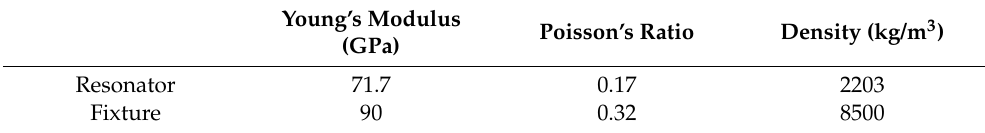
Figure 3. Structural diagram of cylindrical resonator with fixtures and the cylindrical coordinate system. Table 1. Materials of the simulation